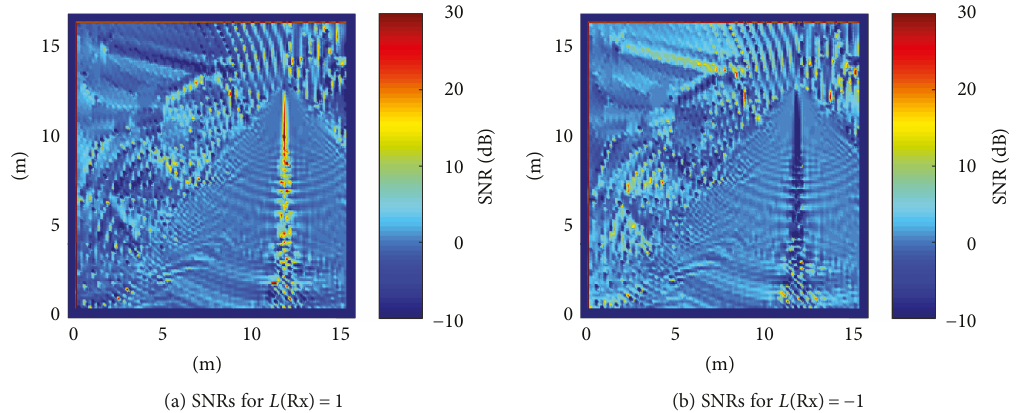
Figure 8: SNRs calculated for the lecture room with the transmitter of L (Tx)=1 using narrow beam width antennas (HPBW 10 ° ).